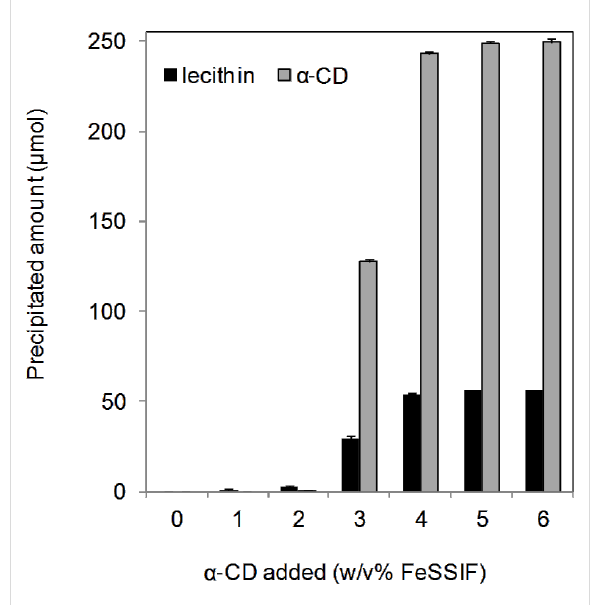
Figure 5: Amounts of lecithin and α -CD precipitates. The amounts of lecithin and α -CD precipitated were calculated from the data shown in Figure 2A and Figure 3, respectively. Means and standard errors are indicated ( n = 3).